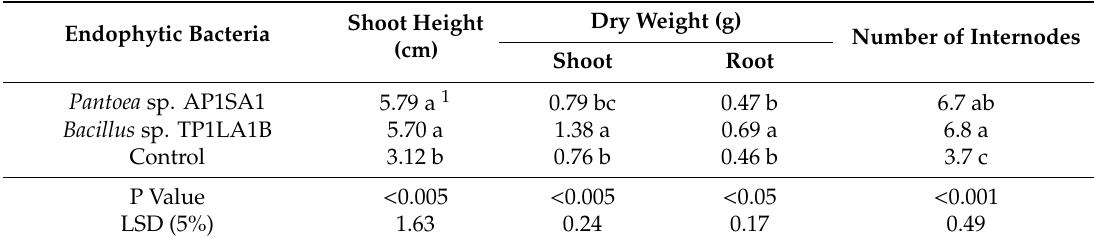
Table 4. Influence of endophytic bacterial treatments on the growth of P. colorata